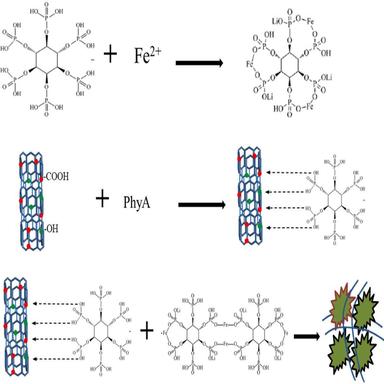
Schematic mechanism for the formation 3D nano-network structure LiFePO4@MWCNTs nanocomposite.